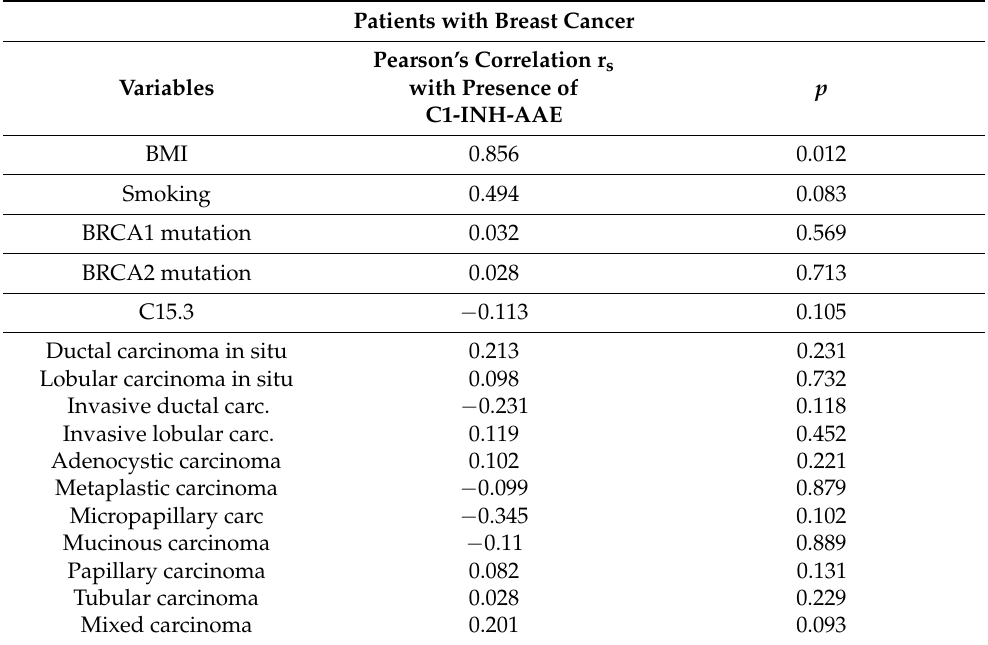
Table 2. The impact of the studied variables on the occurrence of C1-INH-AAE. Patients with Breast Cancer Variables